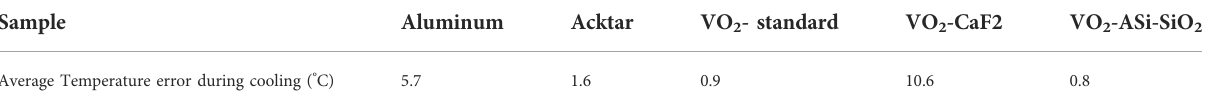
TABLE 4 Average Errors in temperature calculating the temperature from the